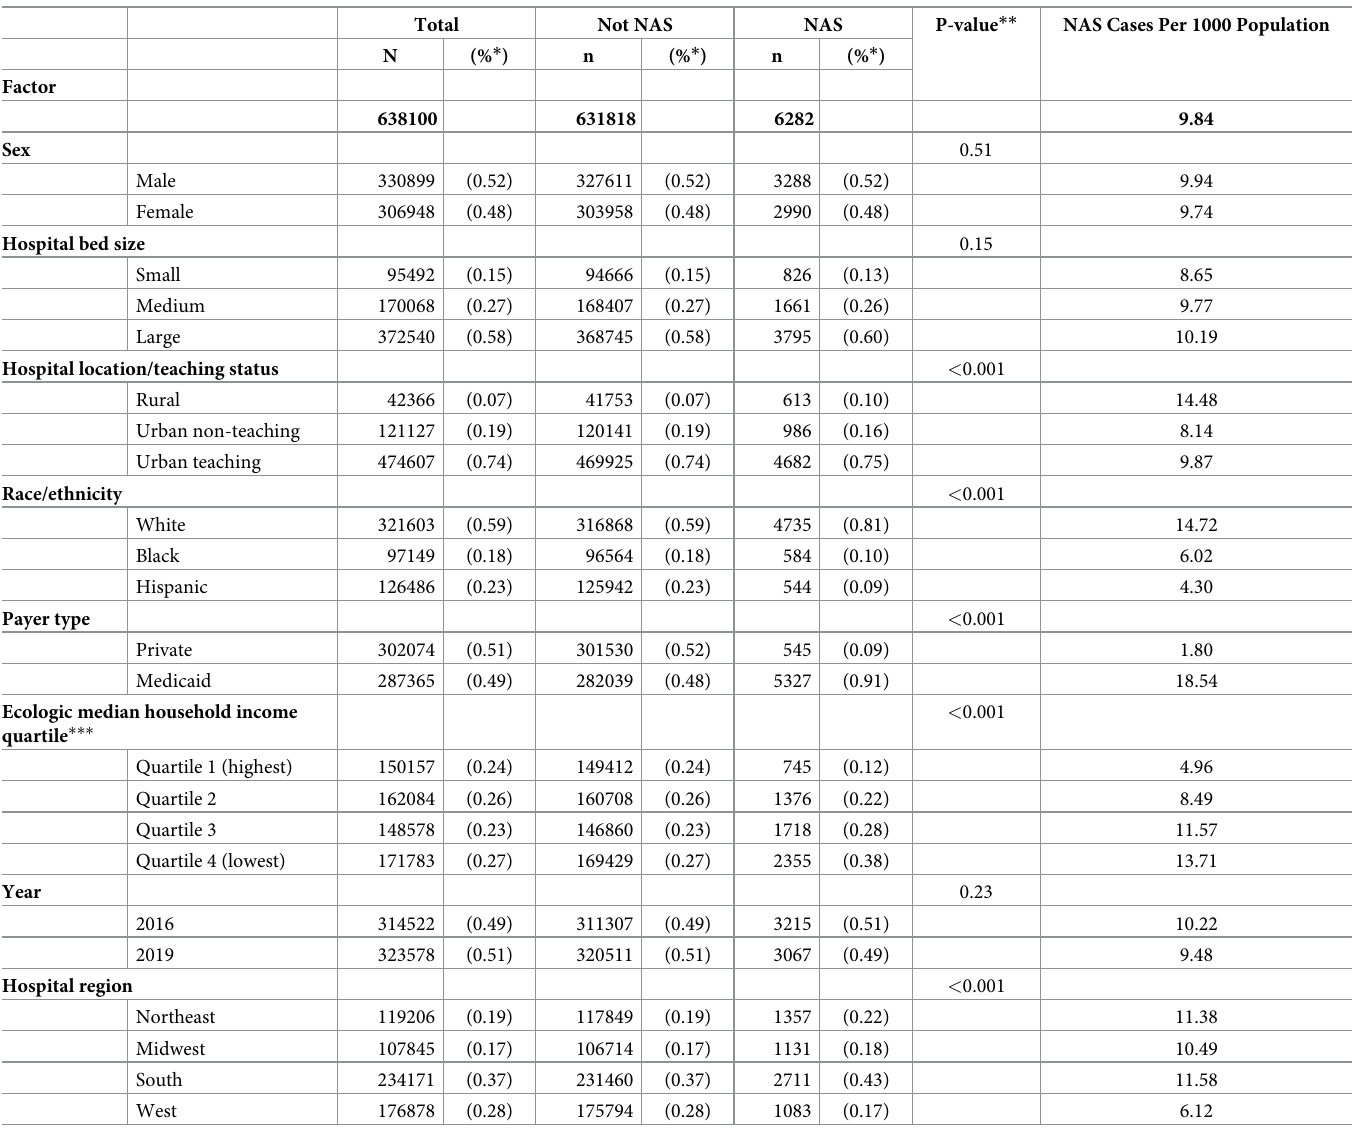
Table 2. Distribution of select population characteristics by NAS